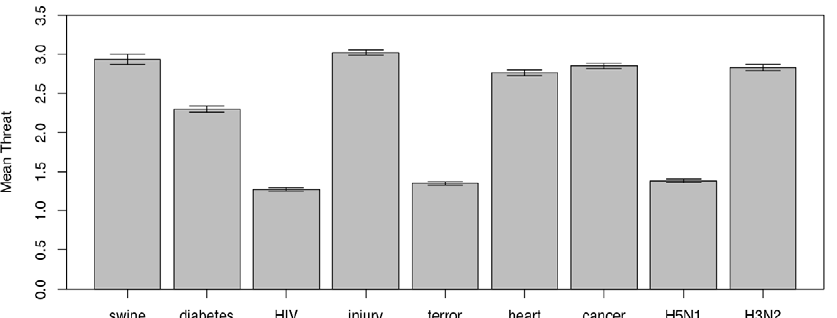
Figure 2. Means for the perceived threat levels for different sources of risk. Bars show Bonferroni-corrected 95% confidence intervals. Codes: 1=no risk, 5=very high risk; ‘‘swine’’=Novel Swine-Origin Influenza A(H1N1), ‘‘diabetes’’=Diabetes mellitus, ‘‘HIV’’=HIV/AIDS, ‘‘injury’’=Unintentional injury, ‘‘terror’’=Terrorism, ‘‘heart’’=Heart Disease, ‘‘cancer’’=Cancer, ‘‘H5N1’’=Bird Flu, ‘‘H3N2’’=Seasonal Flu.